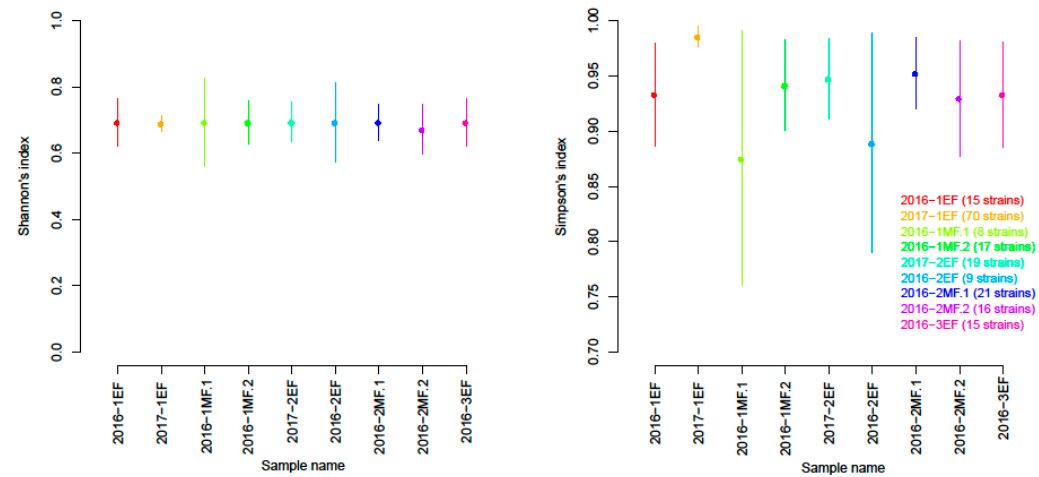
Figure 2. Shannon’s equitability and Simpson’s diversity indices for the S. cerevisiae isolates during the ‘Merwah’ winemaking. The indices were calculated using the poppr package.